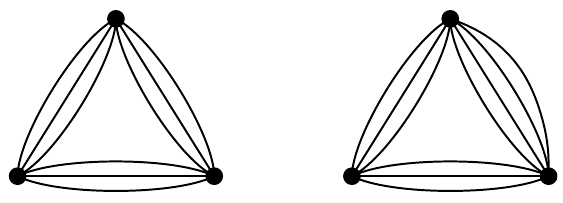
Figure 4: Shannon graphs with ∆ = 6 and ∆ = 7